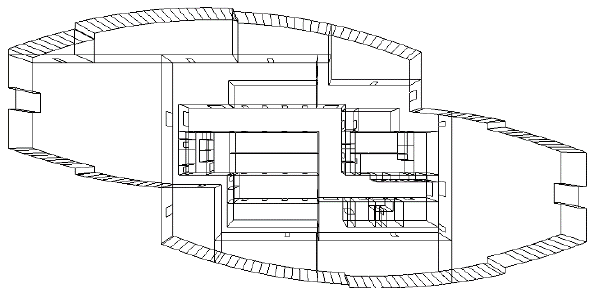
Figure 1. 3D model – one floor from Doha WTC building in Qatar.